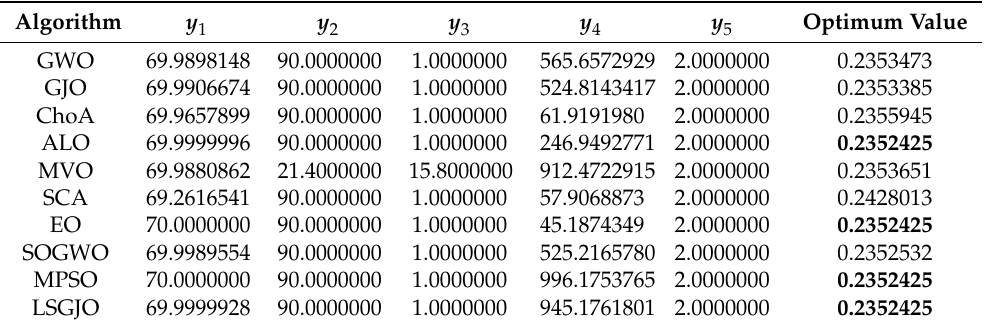
Table 9. Comparison results of multiple-disk clutch design problem. The best results of the exper- iments are shown in bold.